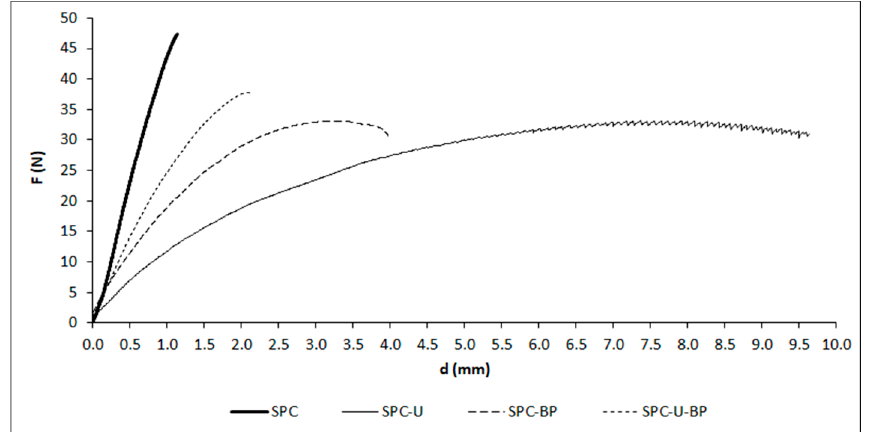
Figure 4. Mean load-displacement curves obtained during the bending test conducted on the injection-molded pieces.